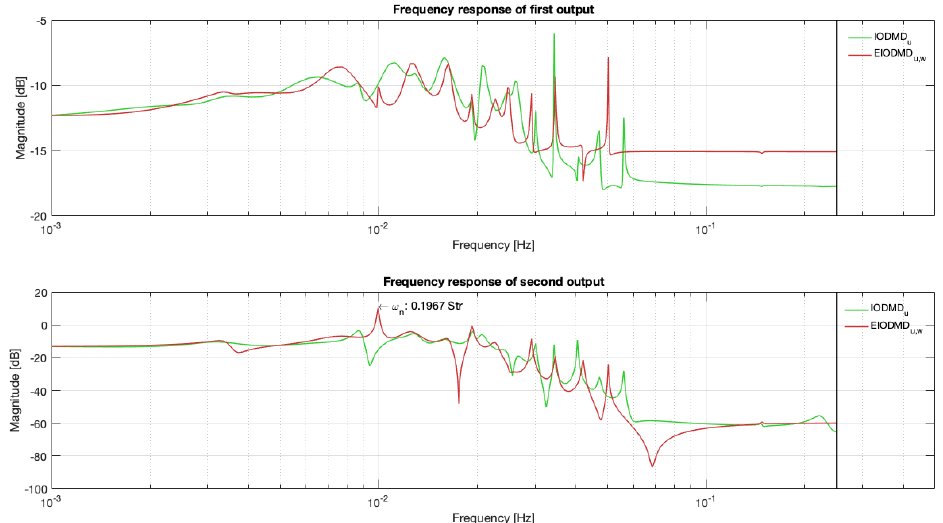
Figure 11. Comparison of IODMD u ( green solid line ) and EIODMD u , w ( red solid line ) model’s response in the frequency domain. The Nyquist frequency, defined as half of the sampling rate, is marked as a vertical black